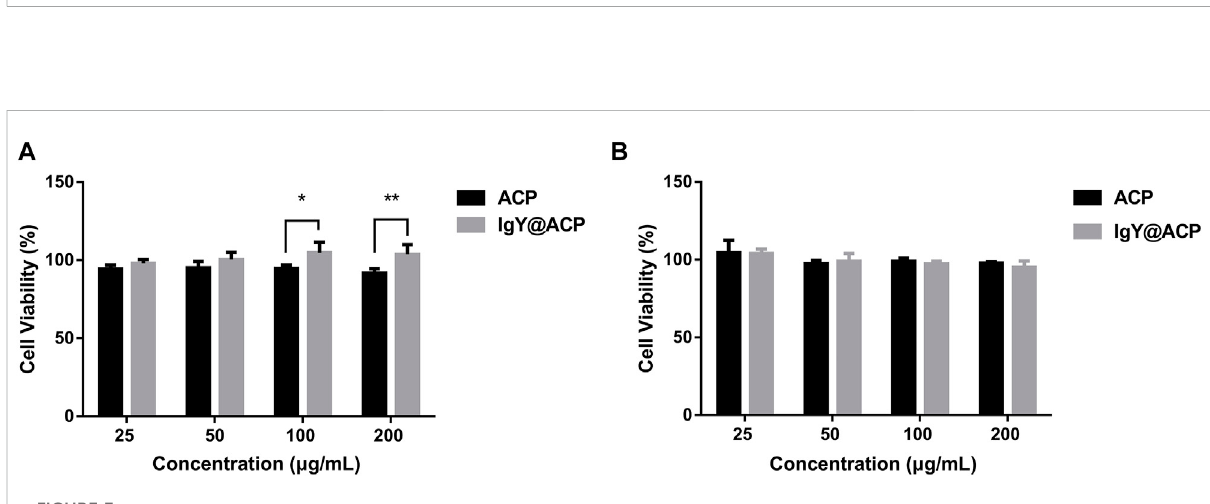
FIGURE 3 ThecellviabilityofHOK (A) andhDPSCs (B) coculturedwithACPandIgY@ACPatdifferentconcentrations(25,50,100,and200 μ